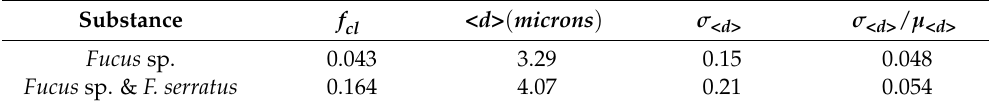
Table 5. Functional fits to the mean spacing of backscatter layers < d >. Table 5 Functional fits to the mean spacing of backscatter layers 〈𝑑〉 .